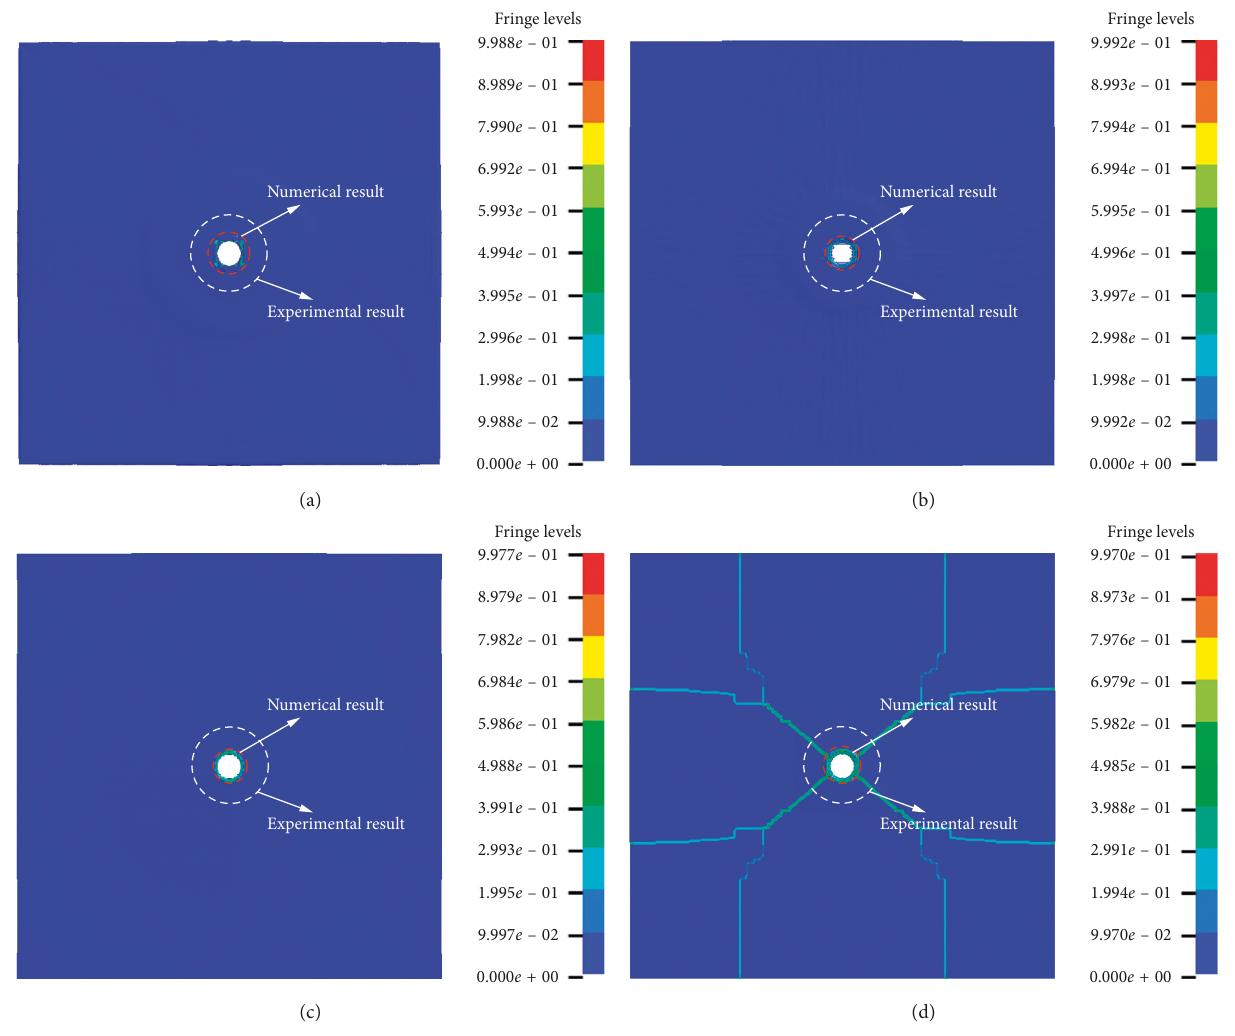
Figure 19: Damage of the FC-RPC target 2 by different models: (a) result of Model A; (b) result of Model B1; (c) result of Model B2; (d) result of Model